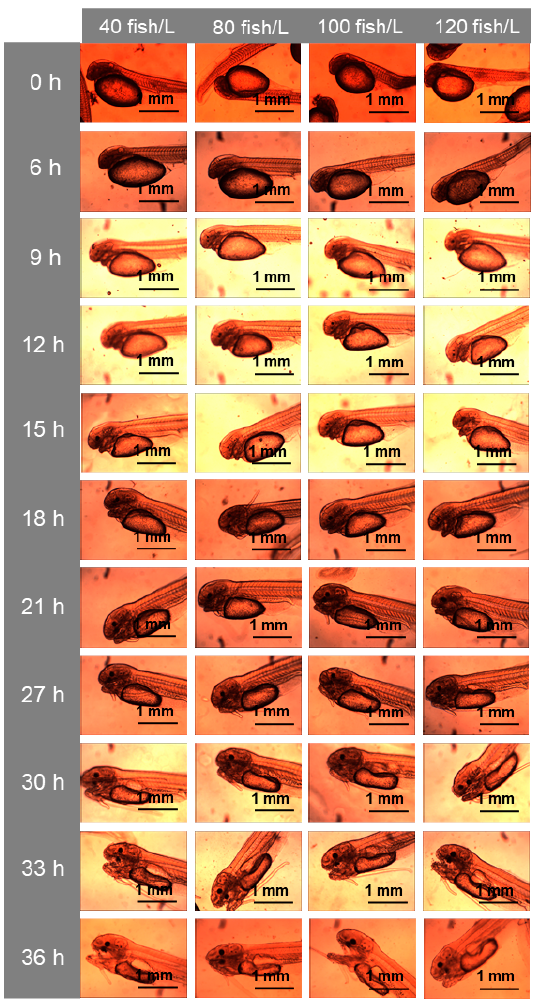
Figure 2. The photographs of striped catfish ( Pangasianodon hypophthalmus ) larvae samples at various stock density treatment levels and hours after hatching in endogenous stage, at mean temperature of 26.08 °C.